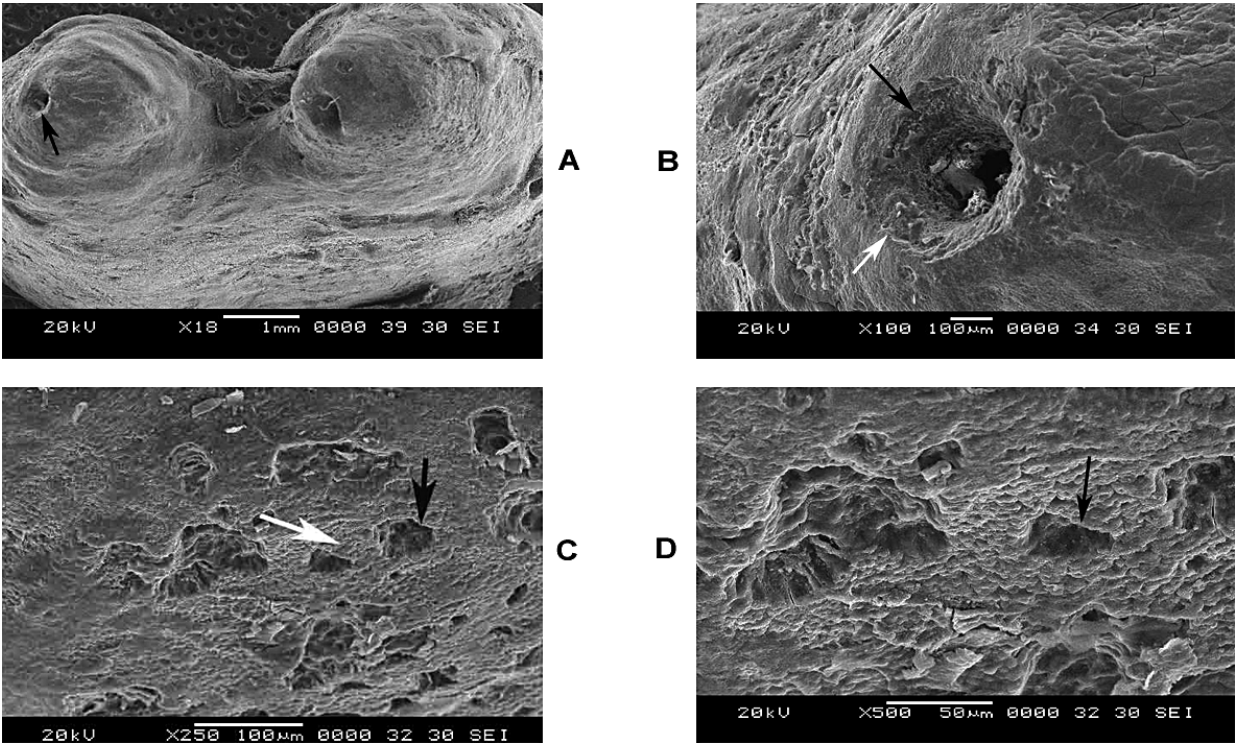
FIGURE 2 (A-D) - Root resorption of permanent molar associated with periapical granuloma at 18x, 100x, 250x, 500x magnifications